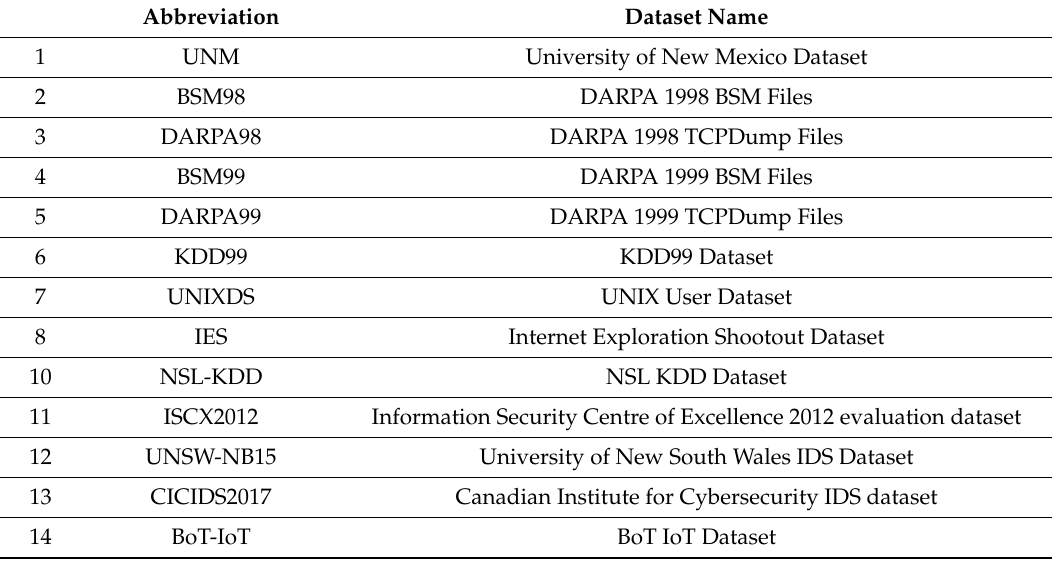
Table 3. Intrusion Detection Domain